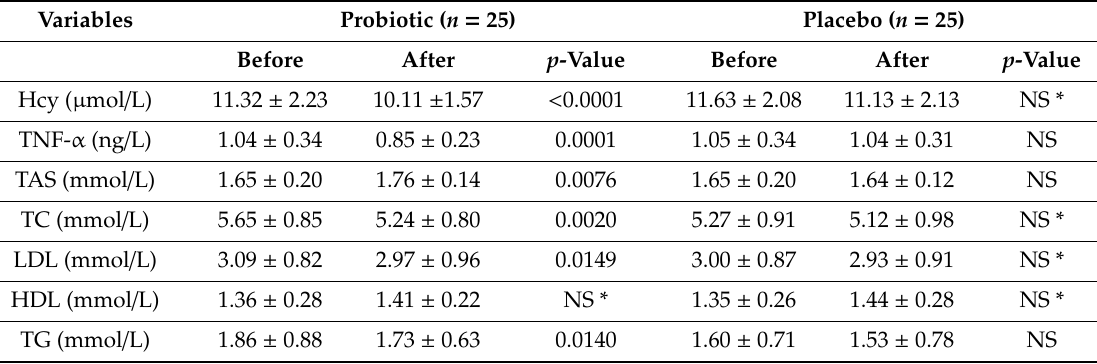
Table 2. Comparative analysis of the Hcy, TNF- α , TAS level and the lipid profile parameters in the probiotic and placebo group before and after intervention.